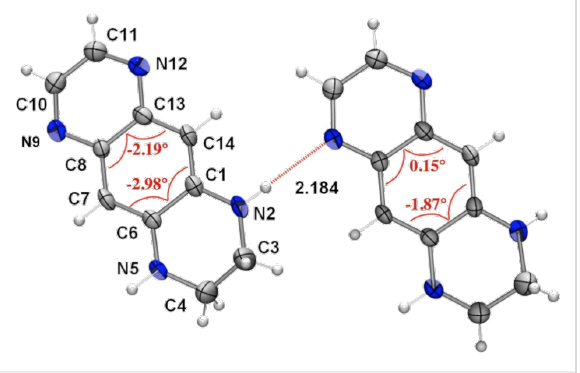
Figure 2: The ORTEP view of 3 . Torsion angles within the benzene ring are given in red. tron donating ethylenediamino moiety (D) toward the electron accepting ethylenediimino (A) moiety as shown by the narrow range of the C–N averaged distances from 1.363 to 1.367 Å (Table 1). The C1–C2 and C4–C5 distances vary between 1.447